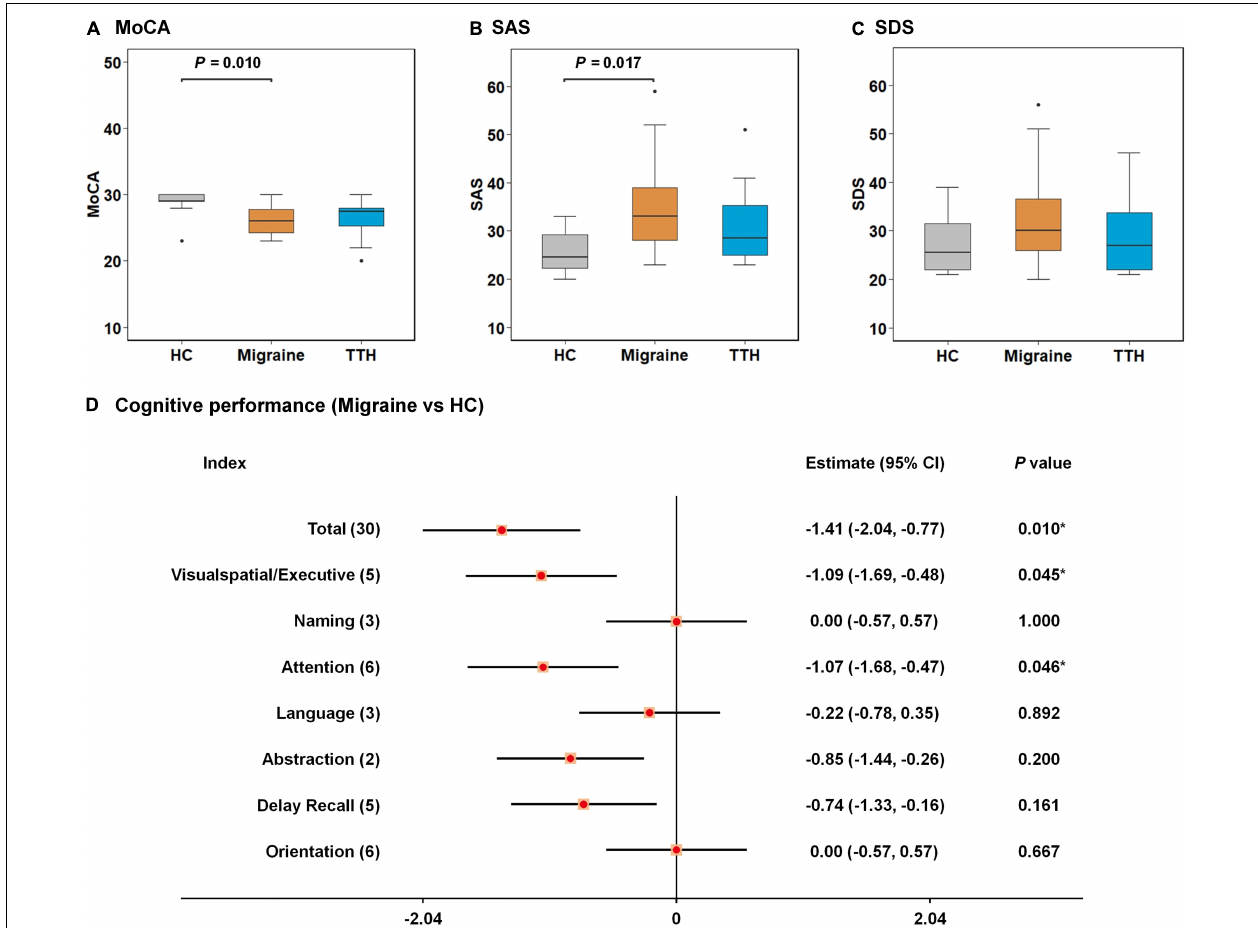
FIGURE 1 | Intergroup differences in neuropsychological tests among healthy control (HC), migraine, and TTH groups. Migraineurs showed lower scores on MoCA (A) and higher scores on SAS (B) than HCs; no significant differences in SDS were observed among the three groups (C) ; the affected cognitive domains in migraineurs were visuospatial/executive functions and attention in comparison with HCs (D) . The intergroup differences were tested using one-way ANOVA and post-hoc analysis. Significant p -values for each pair of intergroup comparisons were depicted at the top of each figure (A–C) ; differences in cognitive performances between migraineurs and HCs were assessed by Welch’s two-sample t -test, and were demonstrated by 95% CI and p -values. * p -value < 0.05 (D) . TTH, tension-type headache; MoCA, Montreal Cognitive Assessment; SAS, self-rating anxiety Scale; SDS, self-rating depression scale; ANOVA, analysis of variance; CI, confidence interval.